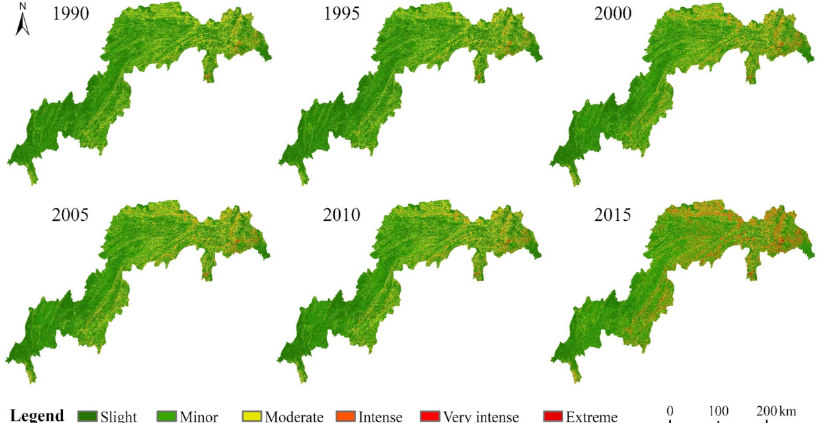
Figure 3. Spatial pattern of soil erosion degree in the TGRA from 1990 to